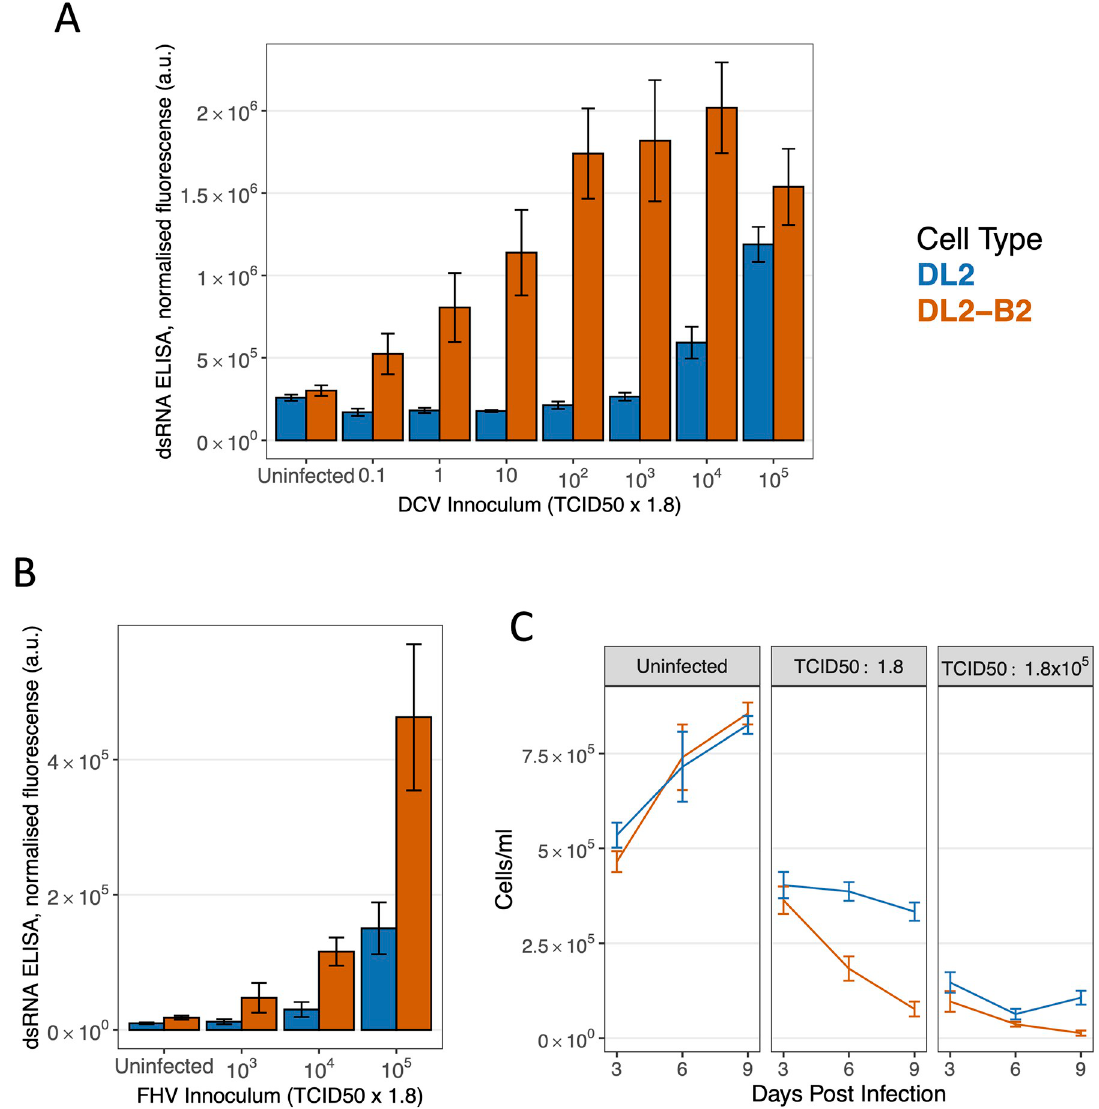
Fig 1. A cell culture system for isolating viruses. (A-B) DL2 cells and DL2 cells expressing the B2 suppressor of RNAi (DL2-B2) were inoculated with a range of doses of DCV and FHV, and dsRNA was detected using ELISA based on J2 monoclonal antibodies 48 hpi. The plot shows mean fluorescence intensity (arbitrary units, a.u.) normalized to cell seeding density. (C) Cell density 3, 6 and 9 days post infection (dpi) with DCV in DL2 and DL2-B2 cells. Error bars represent standard errors. TCID50 was estimated using DL2